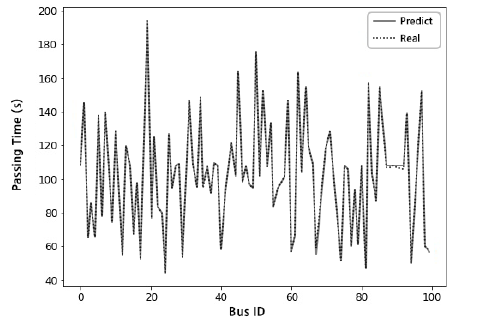
Figure 7. Passing times of buses on a